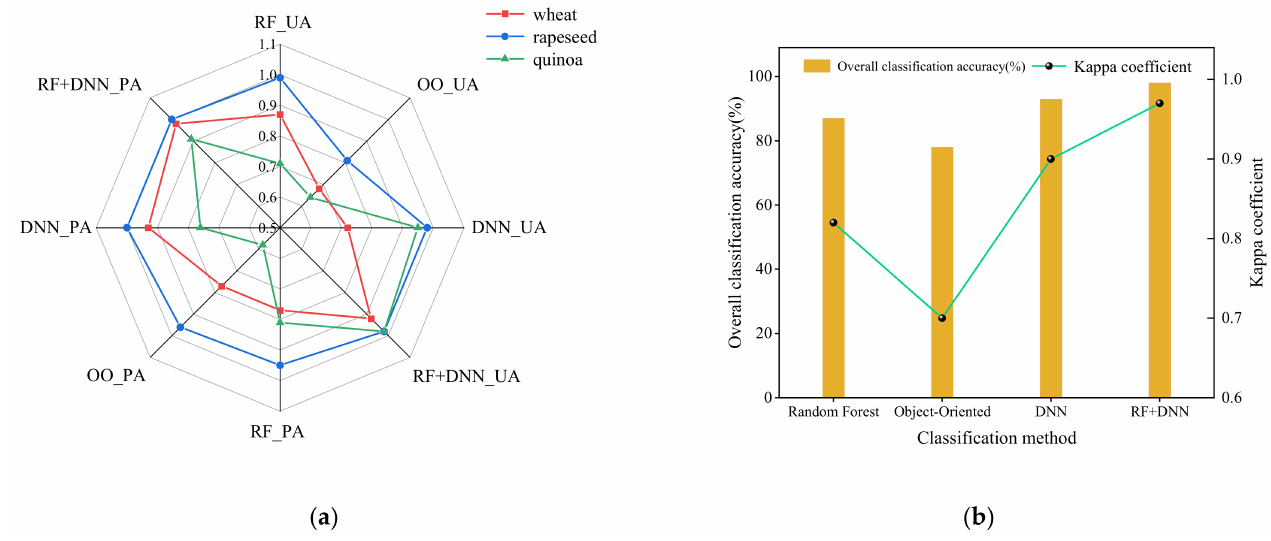
Figure 10. The map of the accuracy of different classification methods. ( a ) Producer accuracy and user accuracy graphs of different crops under different classification methods (RF, OO, DNN, and RF+DNN). ( b ) The overall accuracy and Kappa coefficient of different crops under different classification methods.